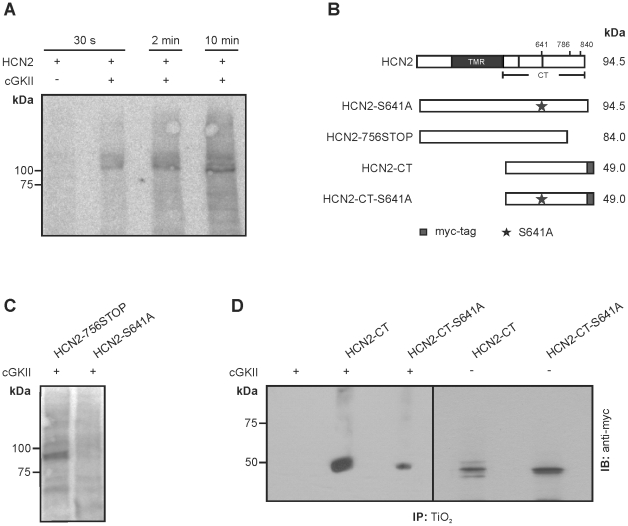
Phosphorylation of HCN2 by cGKII.(A) In vitro phosphorylation of HCN2 by cGKII. Lysates of COS-7 cells expressing HCN2 and cGKII were incubated with [γ-32P]-ATP for the times indicated. After incubation, proteins were separated on SDS page and analyzed by autoradiography. The first lane represents a control reaction with a cell lysate lacking cGKII. (B) HCN channel constructs used for phosphorylation studies. The positions of the three putative cGKII phosphorylation sites (S641, S786 and S840) are indicated. The calculated molecular mass is given for each construct. (C) Phosphorylation assay of a HCN2 mutant lacking S786 and S840 (first lane) and the HCN2-S641A mutant. (D) Pulldown of phosphoproteins by TiO2 beads. Lysates of cells expressing HCN2-CT or HCN2-CT-S641A in the presence or absence of cGKII, respectively, were incubated with TiO2 beads. Proteins specifically bound to the beads were analyzed with an anti-myc antibody.